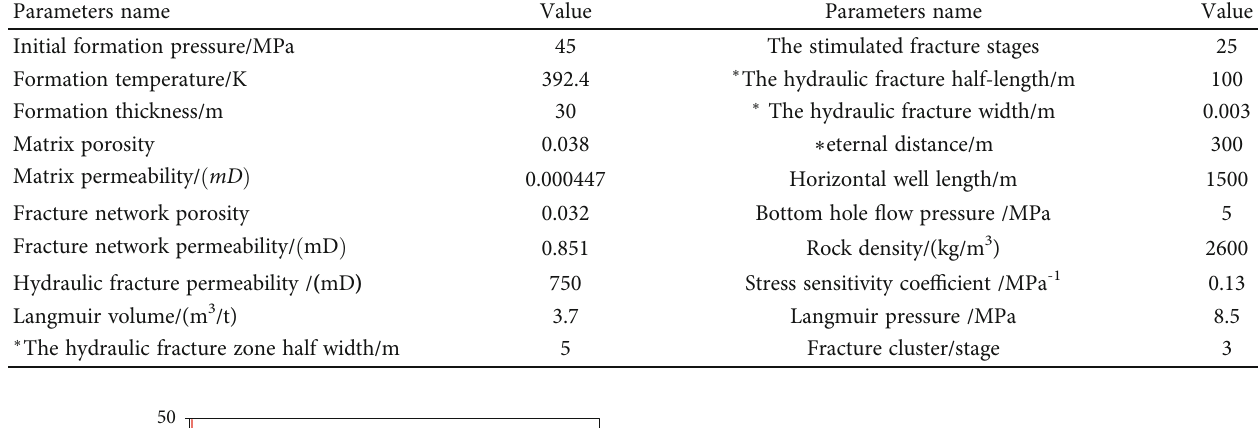
Table 2: Reservoir geological parameters and completion parameters.